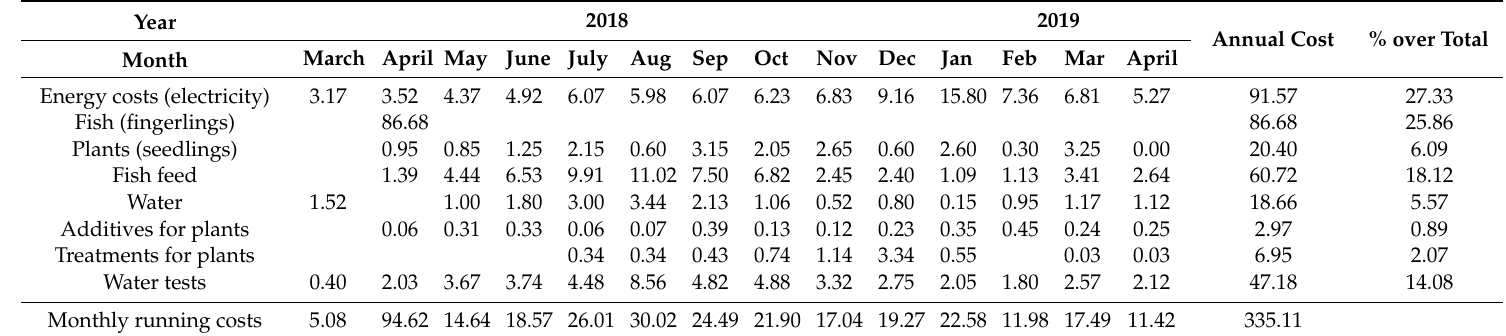
Table A3. Monthly ( € month-1) and annual ( € year-1) running costs for SAS1. Percentage of each input of the total (%) (VAT